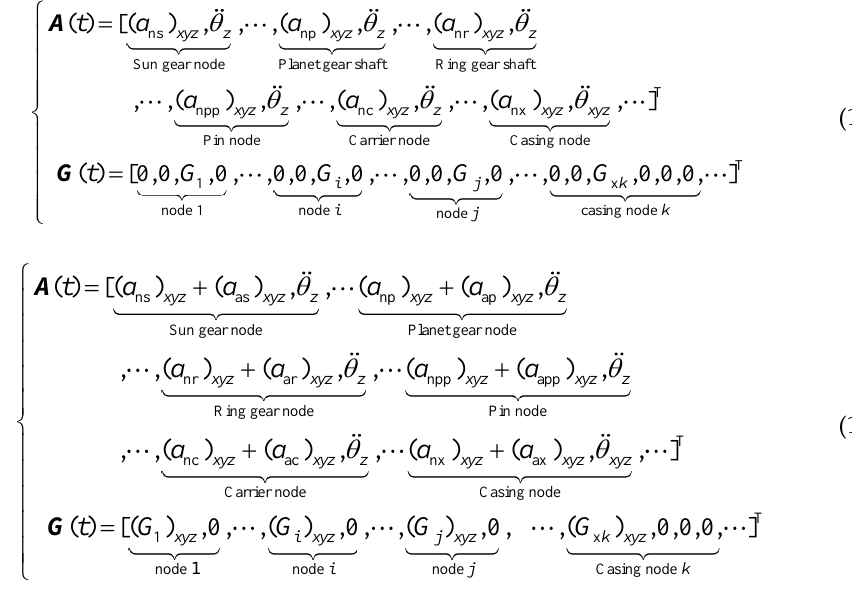
Figure 10. System-level coupled dynamics model of PGT. Figure 10. System‑level coupled dynamics model of PGT.